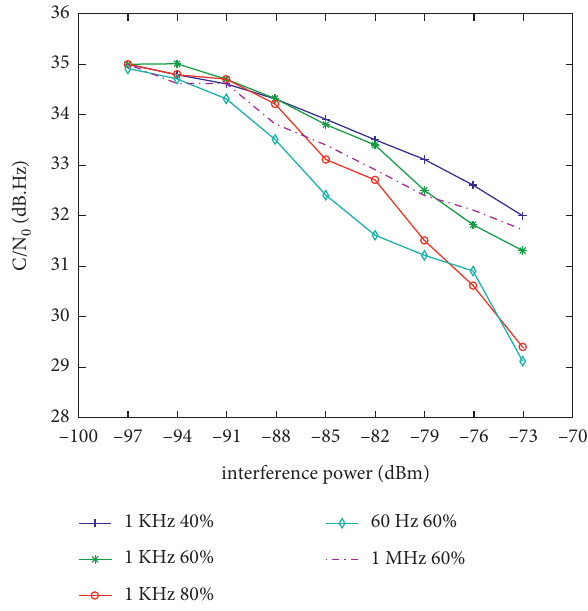
Figure 8: C/N 0 in different pulse parameters